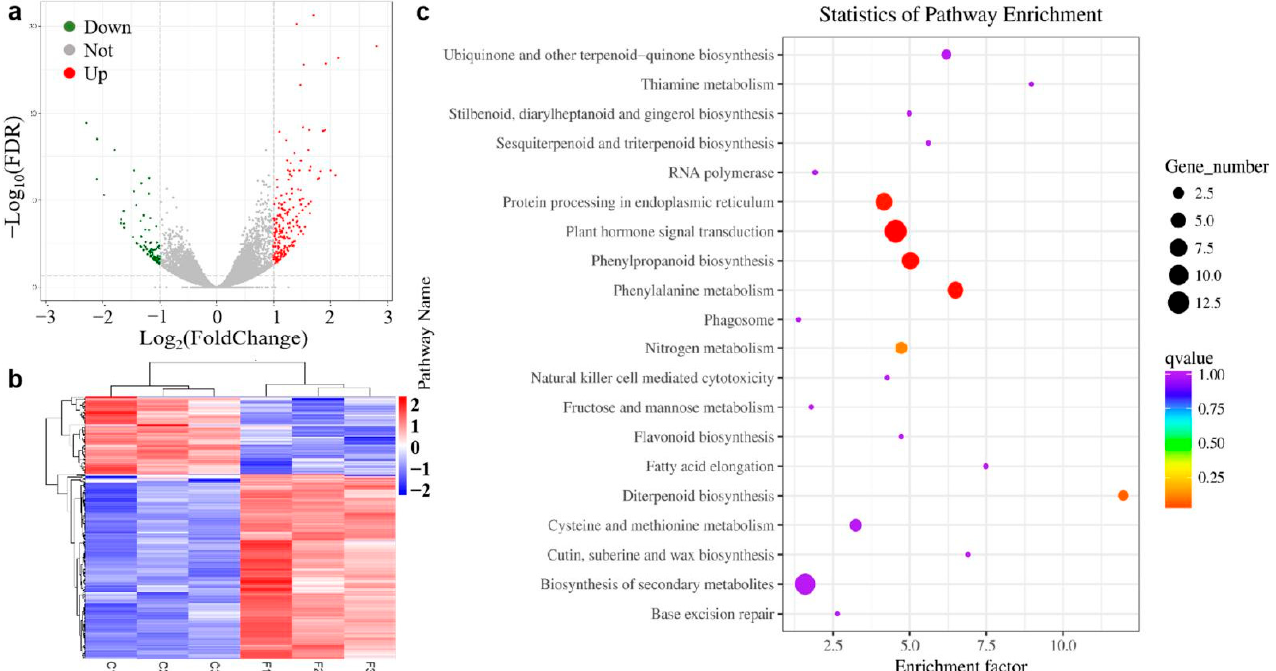
Figure 6. RNA-seq analysis. ( a ) Visualization of RNA-seq results with a volcano plot. The red dots represent differentially expressed genes (DEGs) with log 2 (fold change) ≥ 1 and false discovery rates (FDR) < 0.01, whereas green dots represent DEGs with log 2 (fold change) ≤ − 1 and FDR < 0.01; the black dots represent insignificant DEGs with FC between 0.5 and 2 or FDR ≥ 0.01. ( b ) Hierarchical clustering of analyses of DEGs in the stems of normal (C) and symptomatic (F) plants; 1, 2, and 3 represent the three repetitions. ( c ) Kyoto Encyclopedia of Genes and Genomes (KEGG) pathway enrichment analysis of the DEGs. The X-axis represents the enrichment factor, and Y-axis represents the KEGG pathway. The size of each dot indicates the gene number that was annotated in this pathway. The dot color represents the q-value , with red dots indicating that the pathway was significantly